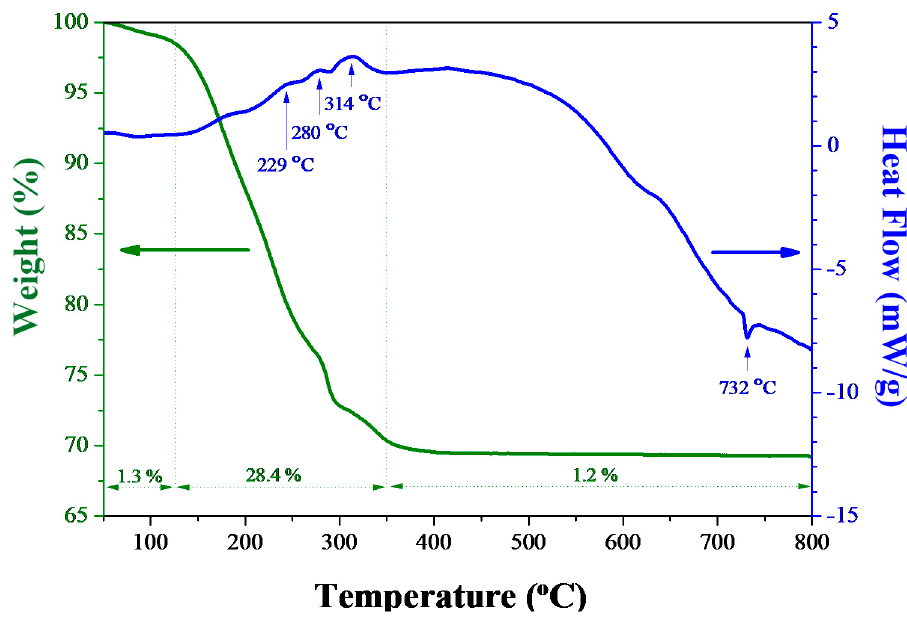
Figure 1. DSC/TGA analytic results of the as-synthesized sol-gel Bi 2 O 3 powders.